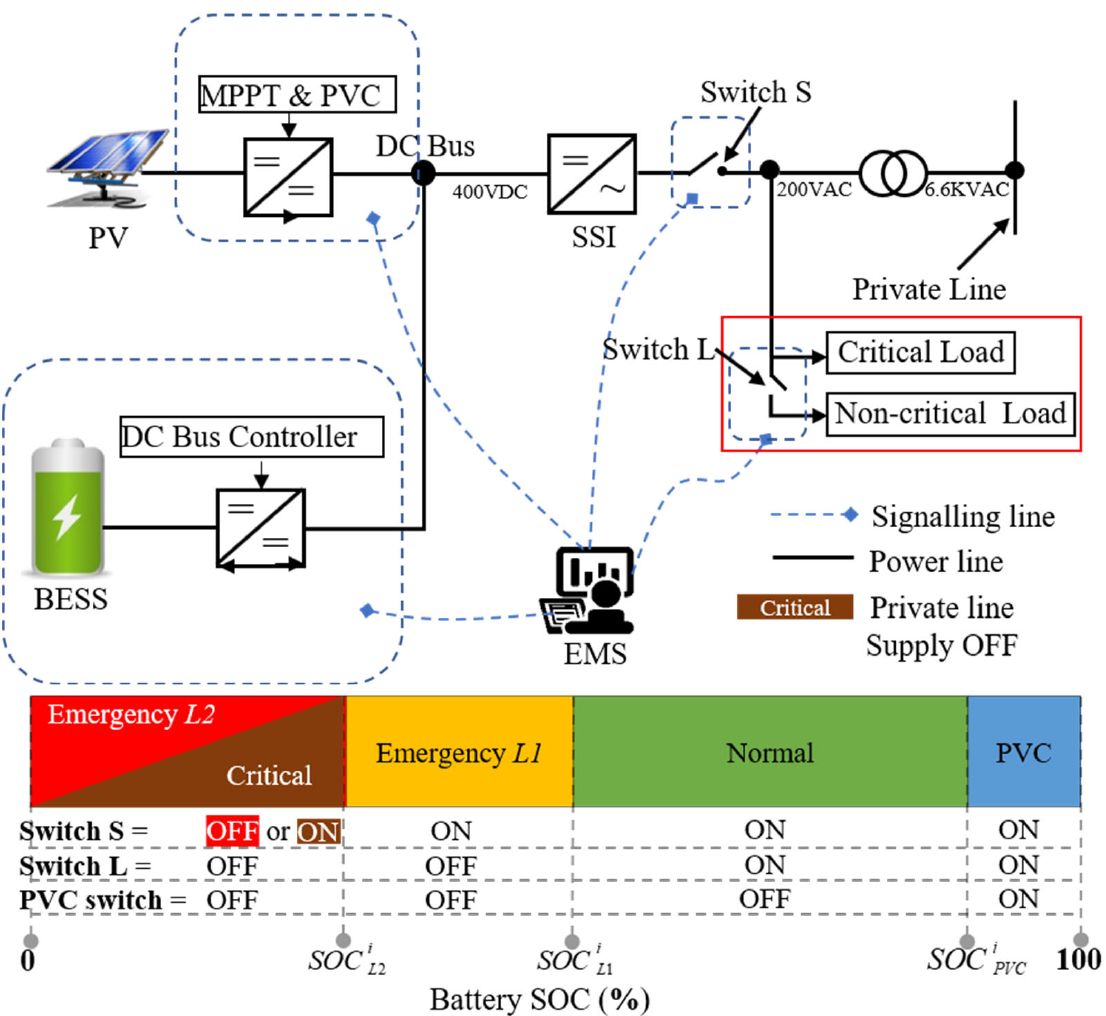
Figure 2. The proposed prosumer model.